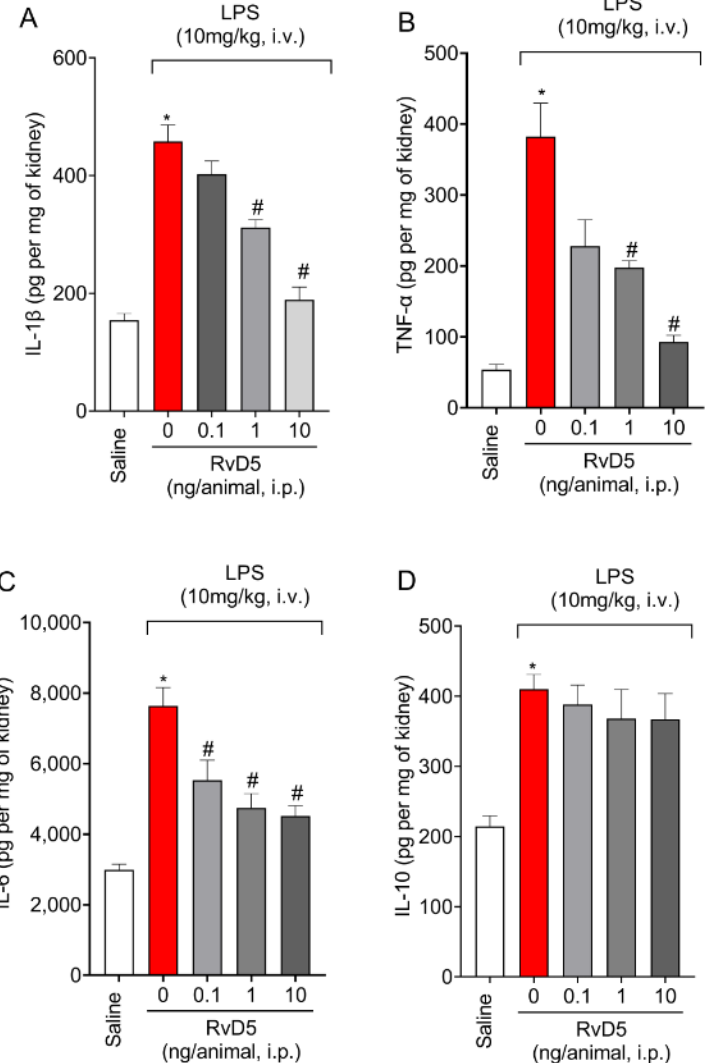
Figure 3. RvD5 reduced LPS endotoxemia-triggered production of IL-1 β , TNF- α and IL-6 without affecting IL-10 levels in the kidneys. IL-1 β ( A ), TNF- α ( B ), IL-6 ( C ) and IL-10 ( D ) levels were determined in kidney homogenates. Results are presented as mean ± SEM of six animals per group and are representative of two replicates. (* p < 0.05 vs. saline, # p < 0.05 vs. LPS 10 mg/kg; one-way ANOVA followed by Tukey’s